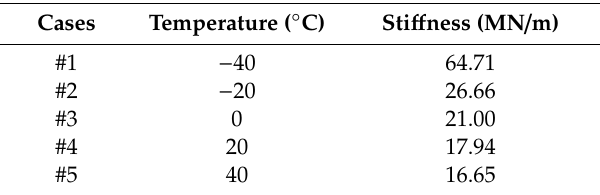
Table 1. Analytical scenarios of WJ-7B small